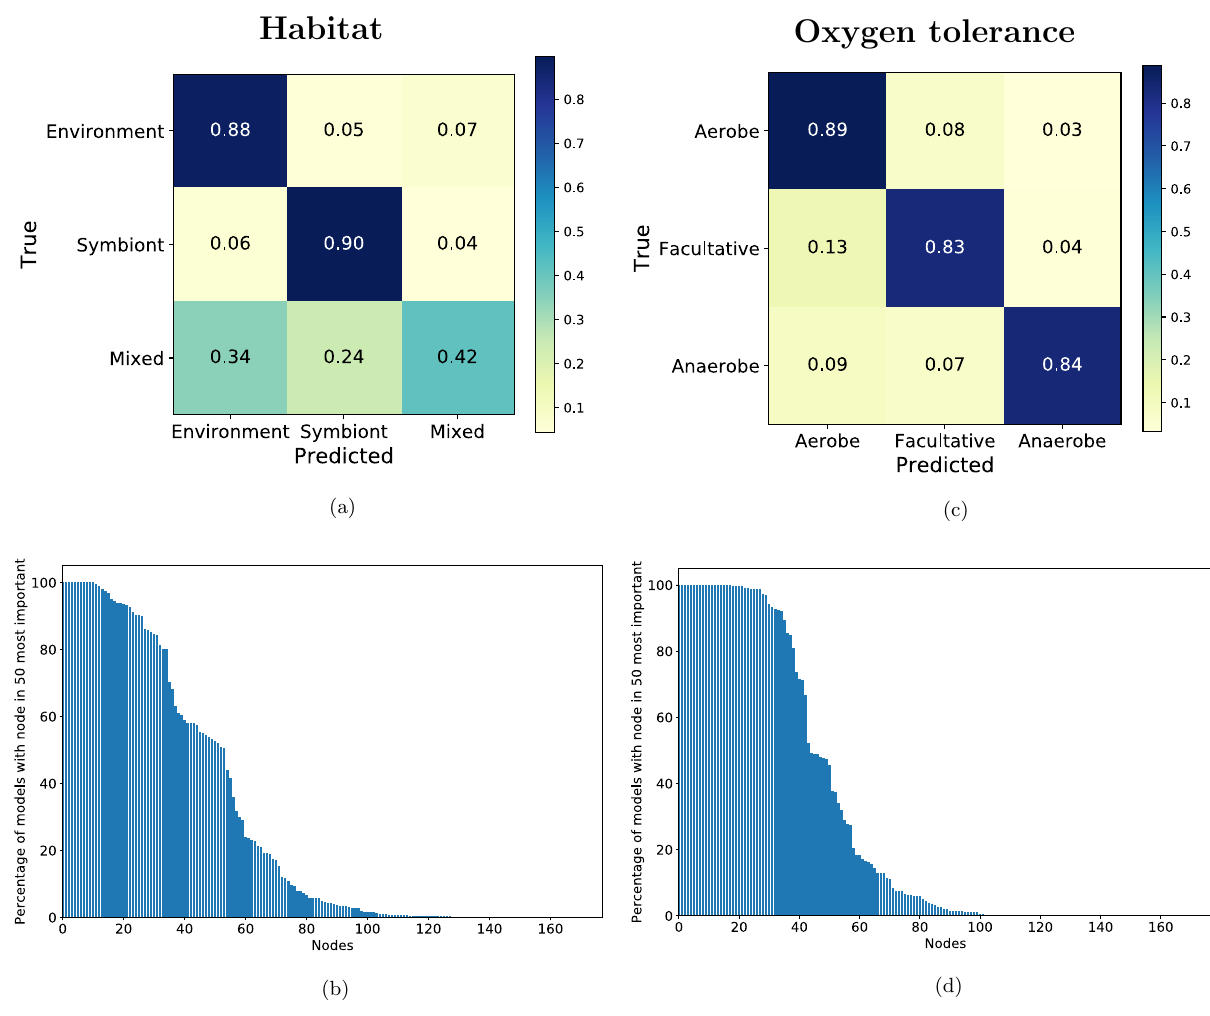
Figure 4. Prediction of habitat and oxygen tolerance using random forest. ( a ) Confusion matrix of a random forest habitat prediction, mean over 300-fold cross-validation. ( b ) Percentage of models (among 300 models obtained by 300-fold cross-validation) including nodes from the 50 most predictive ones, prediction of habitat using the random forest classifier. The 50 most predictive nodes were determined by the Gini impurity for each cross-validation model. ( c ) Normalised confusion matrix of a random forest oxygen tolerance prediction, mean over 300-fold cross-validation. ( d ) Percentage of models (300 models obtained by the cross-validation using the random forest) including nodes from the 50 most predictive ones, prediction of oxygen tolerance using the random forest classifier. The 50 most predictive nodes were determined by Gini impurity for each cross- validation